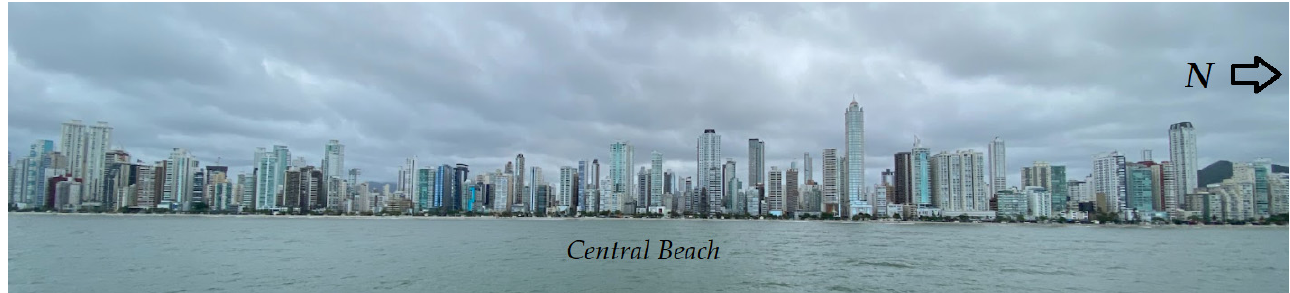
Figure 2. Panoramic view of the waterfront of Balneário Camboriú/SC, Brazil. Source: Authors, taken during fieldwork,